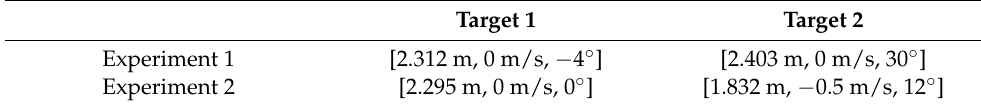
Figure 11. Experimental scenarios. ( a , c ) are the experimental scene and model diagram of experiment 1, there are two stationary targets in the experiment. ( b , d ) are the scene and model diagram of experiment 2, one stationary and one moving targets in the experiment. Table 2. Specific information of